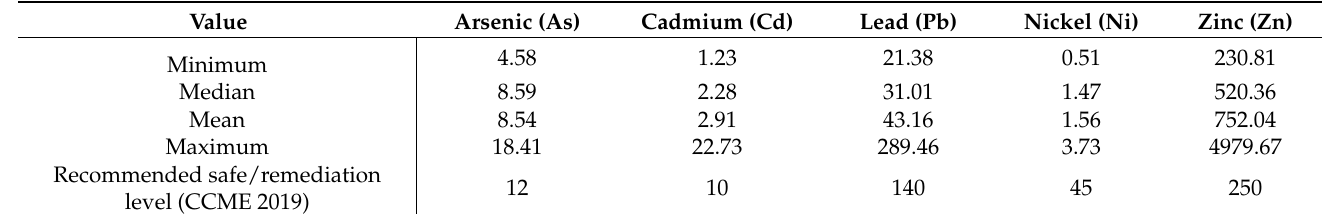
Table 1. Mukuru Soil Concentrations of Metals in (mg/kg dry weight ).